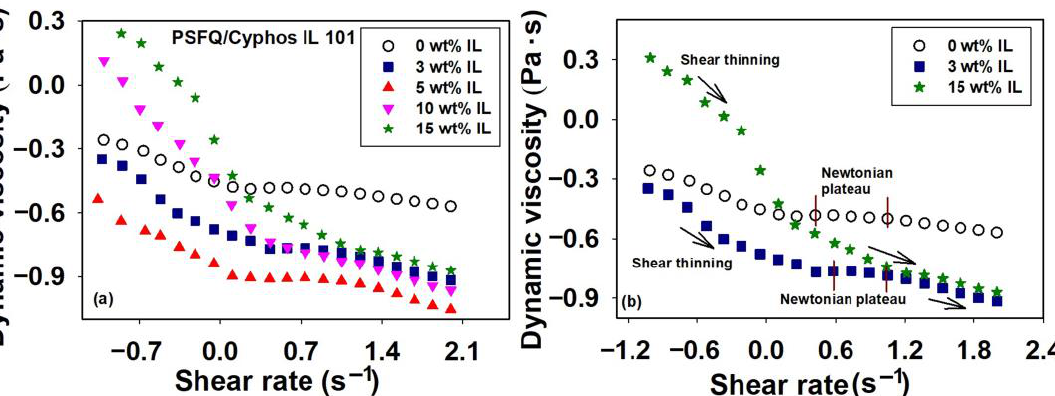
Figure 1. Rheological profile illustrated by double—logarithmic plots of dynamic viscosity ( η ) versus shear rate ( γ̇ )for PSFQ/Cyphos IL 101 system at 25 °C and various mixing ratios, namely ( a ) Cyphos IL 101 compositions varying between 3 wt% and 15 wt% and ( b ) Cyphos IL 101 compositions of 3 wt% and 15 wt%, shown for a better visualization of the viscosity changes in the three regions.